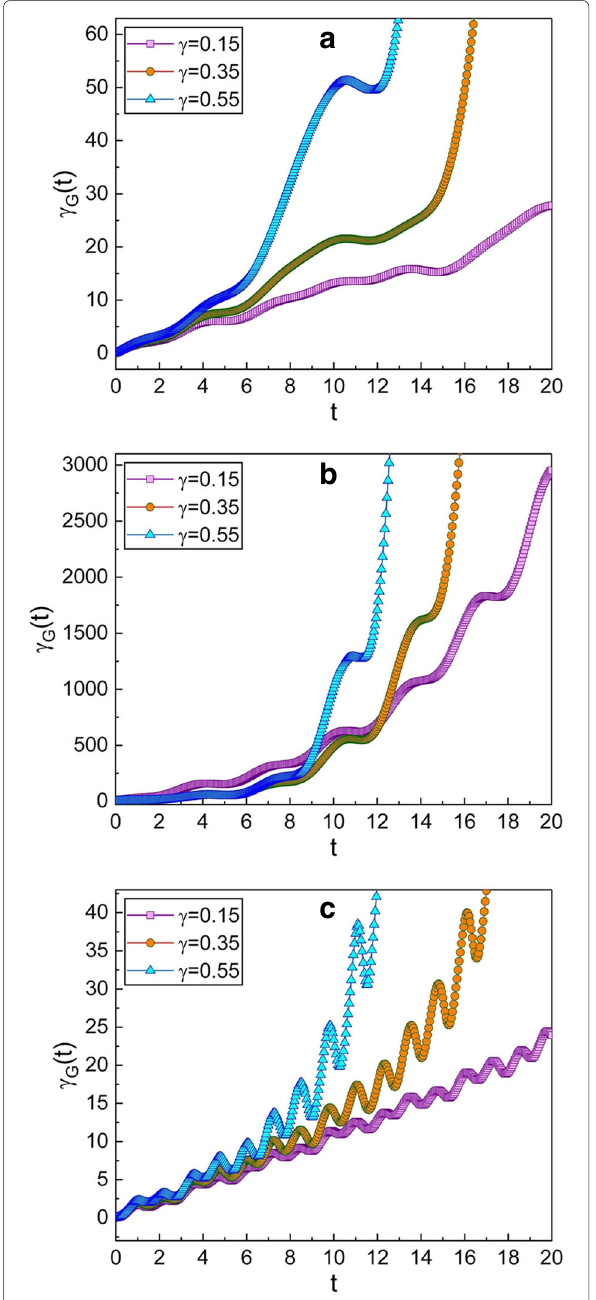
Fig. 3 a – c This graphic is the same as Fig. 2, but for the case that the √ 2 and ν = − 1 which give a chosen squeezing parameters are μ = p -squeezed state at initial time. From the fact that the overall graphics in this case are not so much different from the corresponding ones of Fig. 2, we can confirm that the evolution of γ G ( t ) is nearly irrelevant to the types of squeezing so long as the absolute values of μ and ν do not change